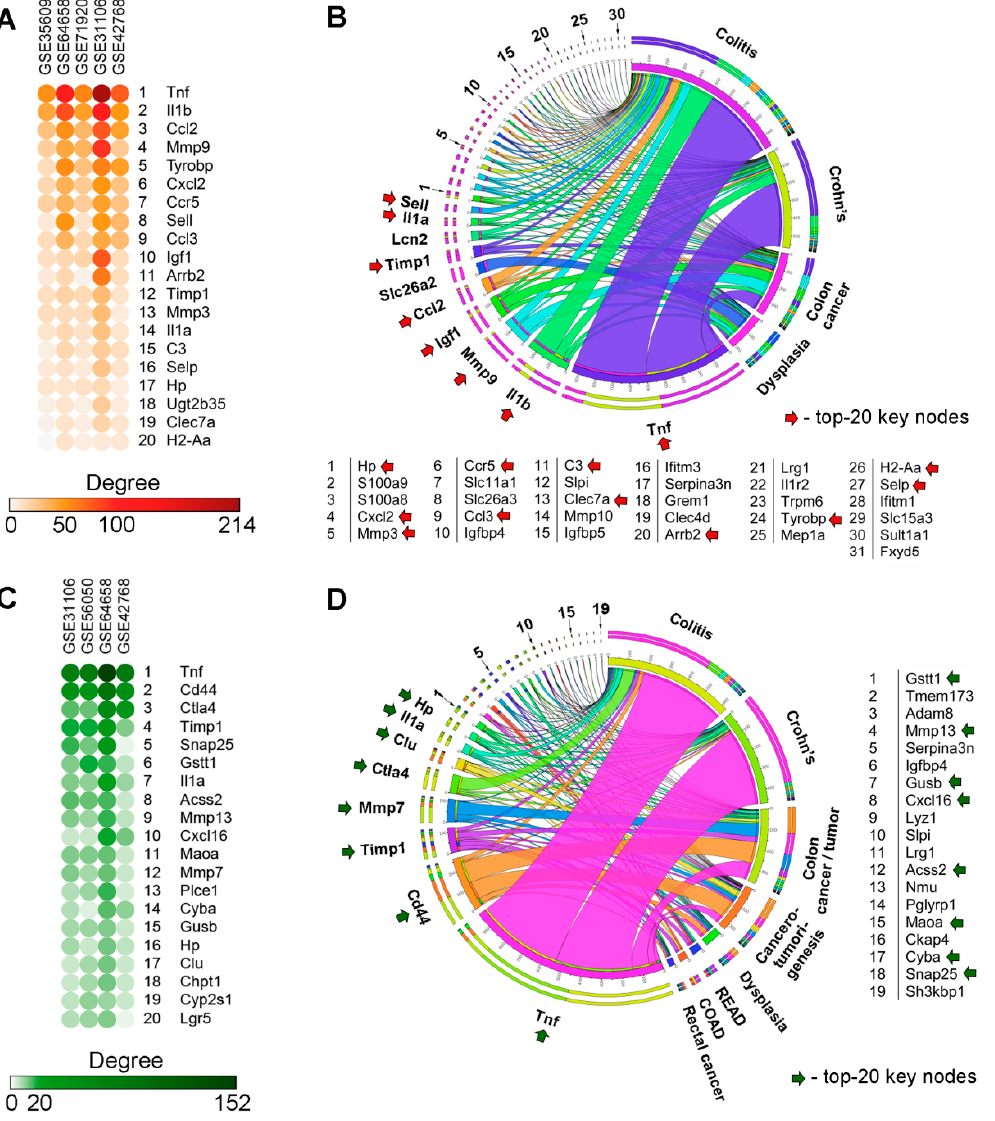
Figure 2. Core genes characterized by hub position within acute colitis- and CAC-related regu- lomes. ( A , C ) Heatmaps demonstrating interconnection of core genes in gene association networks reconstructed for each acute colitis- ( A ) and CAC-related ( C ) dataset using the STRING database (confidence score ≥ 0.7). Only the top 20 of the most interconnected hub genes are represented. ( B , D ) Co-occurrence of revealed hub genes with keywords associated with colitis ( B ) and CAC ( D ) in the scientific literature deposited in the MEDLINE database. Analysis was performed using the GenClip3 tool. Data were visualized using Circos. COAD and READ-association of the aberrant expression of hub genes with poor prognosis in patients with colon and rectal adenocarcinomas, respectively, according to the TCGA database.